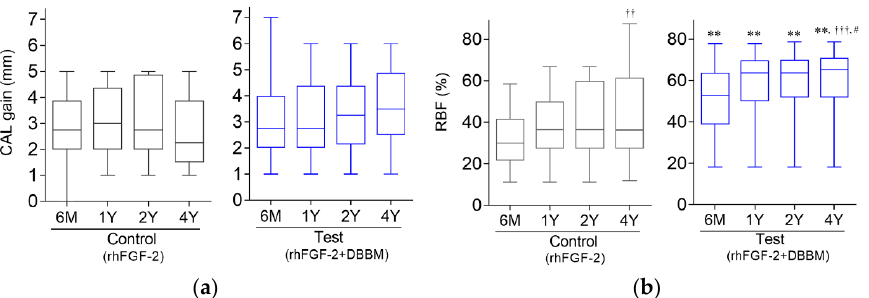
Figure 2. Clinical attachment level (CAL) gain ( a ) and radiographic bone fill (RBF) ( b ). The chart shows maximum, median, minimum, and 25th and 75th percentiles. ** p < 0.01, compared to the control group by Mann–Whitney U test. †† p < 0.01, ††† p < 0.001 compared to 6 months; # p < 0.05 compared to 1 year, Friedman test with Dunn post hoc test.